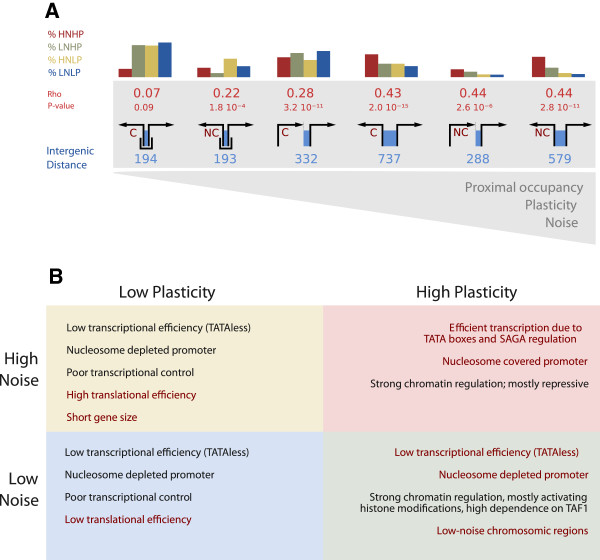
Noise plasticity coupling is modulated by genomic neighborhood and distinguishes four control strategies overall.A). A cartoon depicting the different genomic structures (bipromoter, parallel, divergent) upstream of coding genes is shown in ascending order of proximal nucleosome occupancy, plasticity and noise (which coincide). For each structure, we show the average intergenic distance in blue. In red is shown the Spearman ρcoefficient for the observed noise-plasticity correlation. We also show the percent within each class of a given upstream structure , e.g., HNHP mostly exhibit parallel/divergent coding (C) and divergent non-coding (NC) transcripts. B) Four regulatory strategies broadly adjust the noise-plasticity coupling. These strategies emphasize the alternative transcriptional- or translational-based modes of balancing noise and plasticity in yeast.